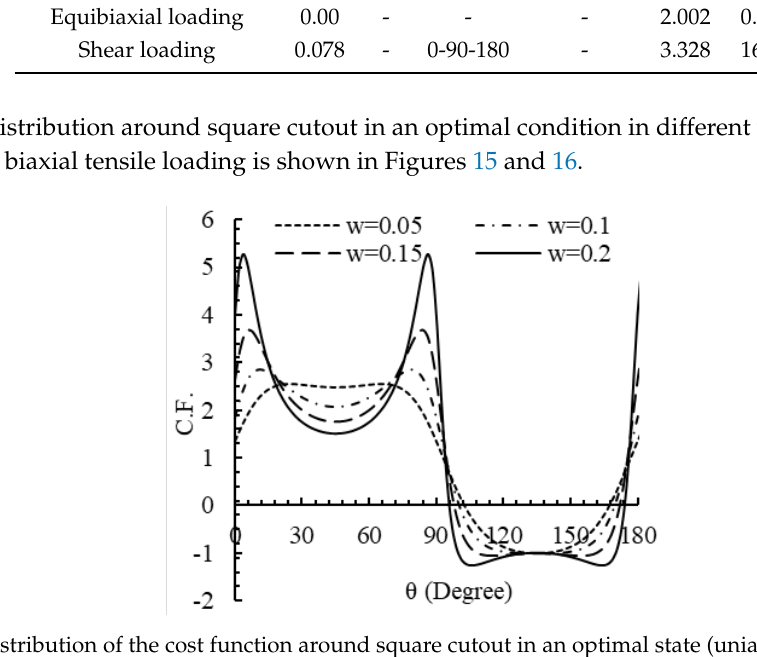
Figure 15. Distribution of the cost function around square cutout in an optimal state (uniaxial tensile loading).